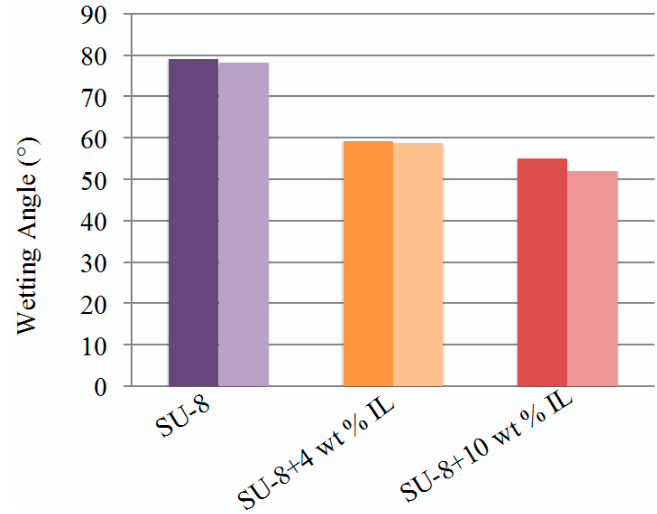
Figure 3. Wetting angles of water droplets on different surfaces. Each bar represents an independent measurement.